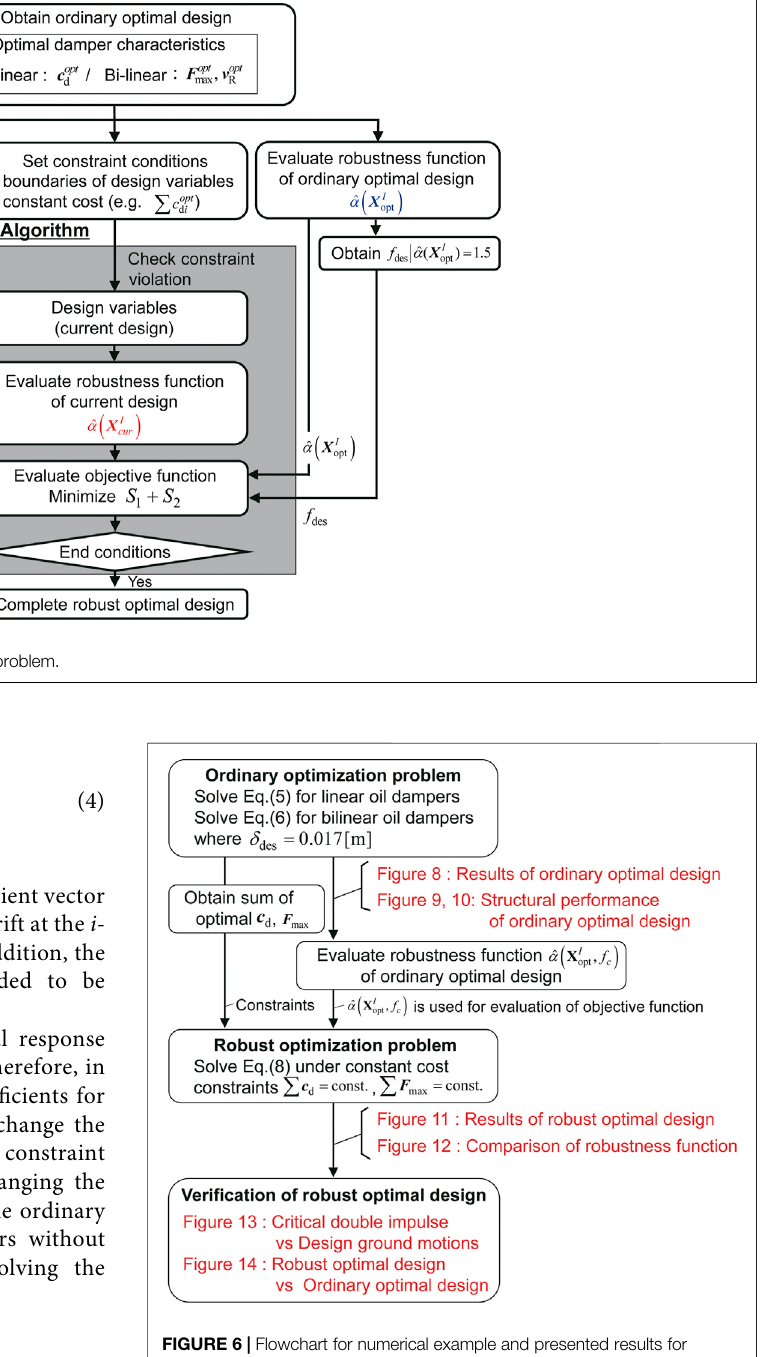
FIGURE 6 | Flowchart for numerical example and presented results for each